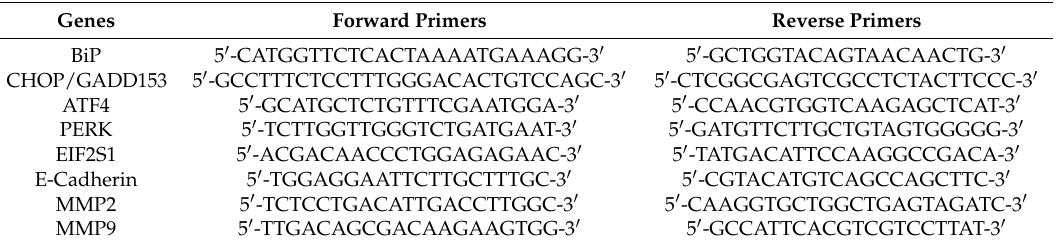
Table 1. Forward and reverse primer sequence of genes chosen in this